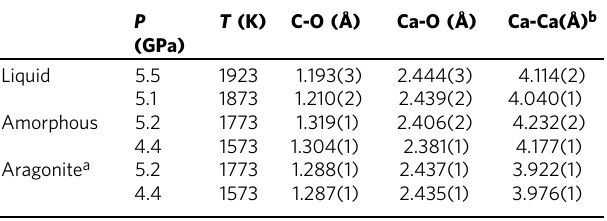
Table 1 The bond lengths of C-O, Ca-O, and Ca-Ca in aragonite, amorphous, and liquid CaCO